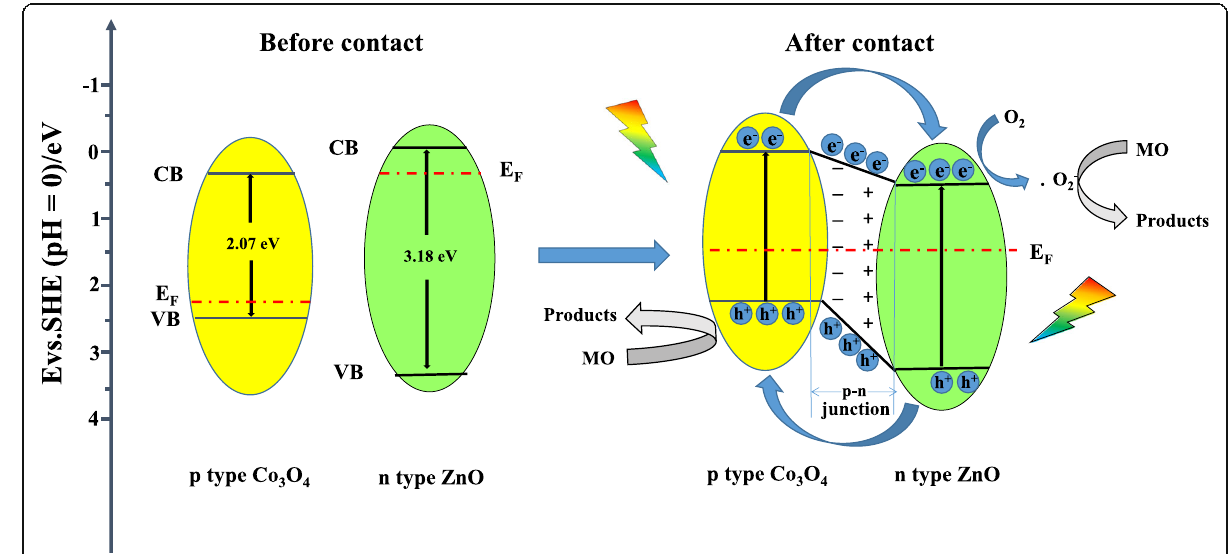
Fig. 15 Schematic diagram of photocatalytic mechanism of Co 3 O 4 /ZnO-35 composites under UV irradiation